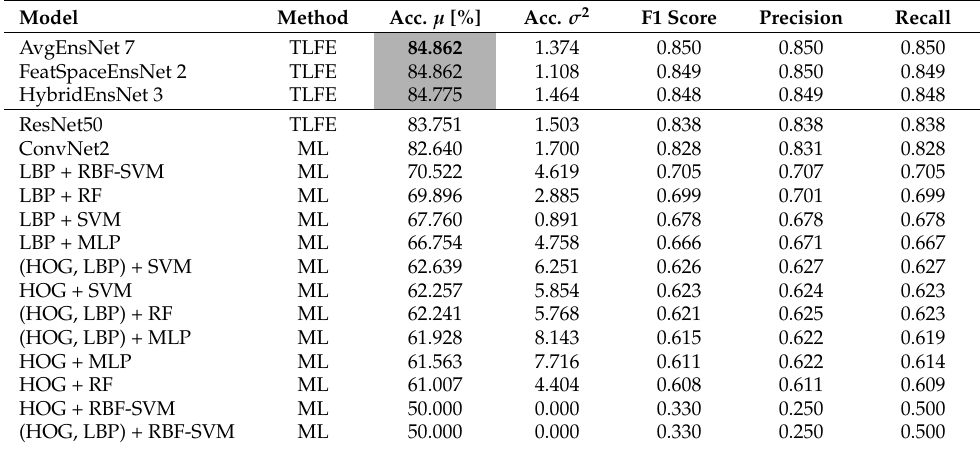
Table 6. Performance of all models and methods applied with the corresponding number of parame- ters.